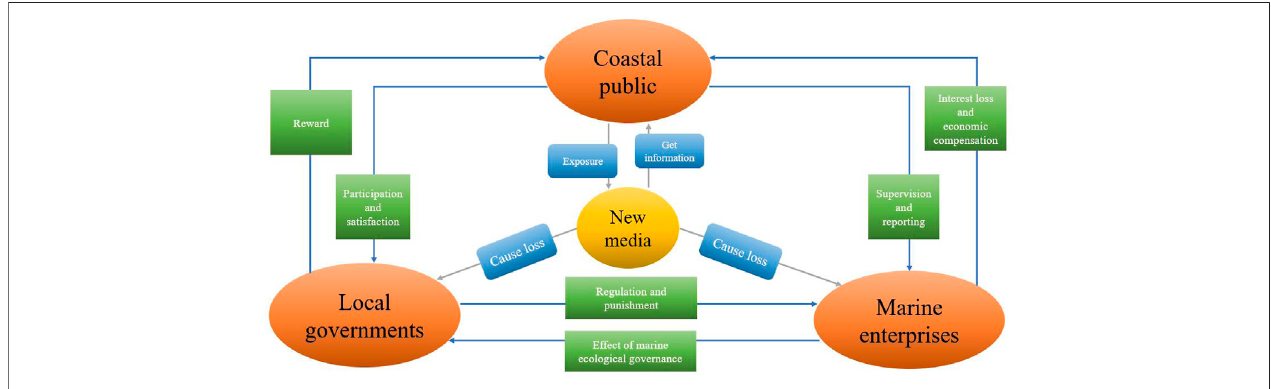
FIGURE 1 | Diagram of the logical relationships in the tripartite evolutionary game